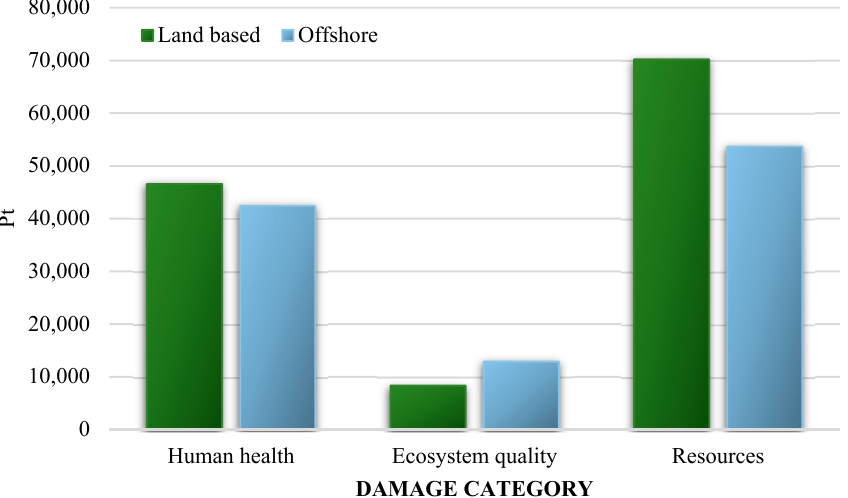
Figure 9. Results of grouping and weighing environmental effects for impact areas occurring in life cycles of land-based and offshore wind power plants. Authors’ own research.